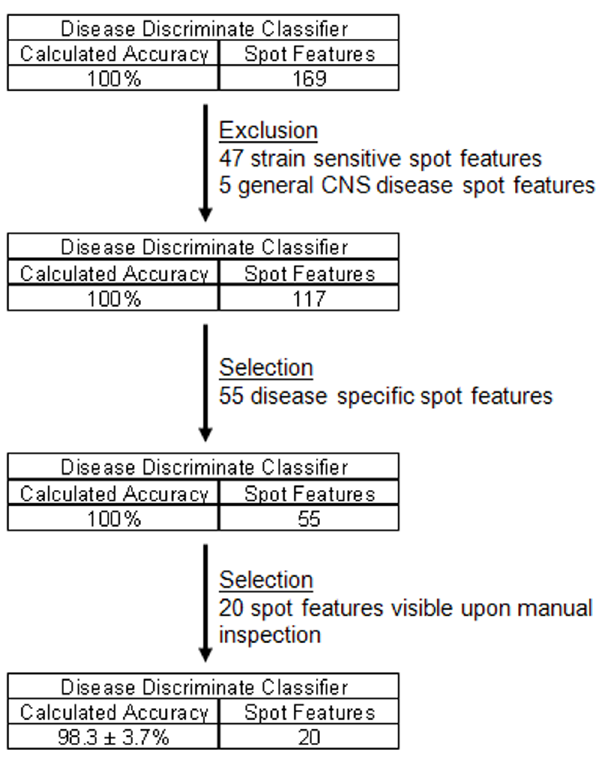
Figure 5. Flow chart depicting the development of the Disease Discriminant Classifier based upon 20 identified proteins from the 169 proteins that were present in 80% of the 38 gel images representing the clinical stage Alzheimer and scrapie sample sets exhibiting significant differential abundance (ANOVA p #